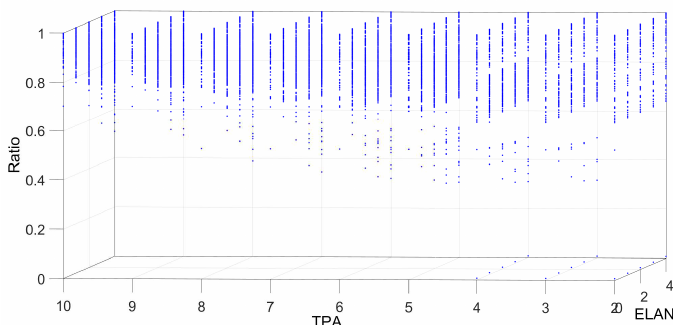
Figure 8. Relationship between the excitation level in neighbours (ELAN) and its associated threshold TPA. The production of output events increases in the case of high TPA and high